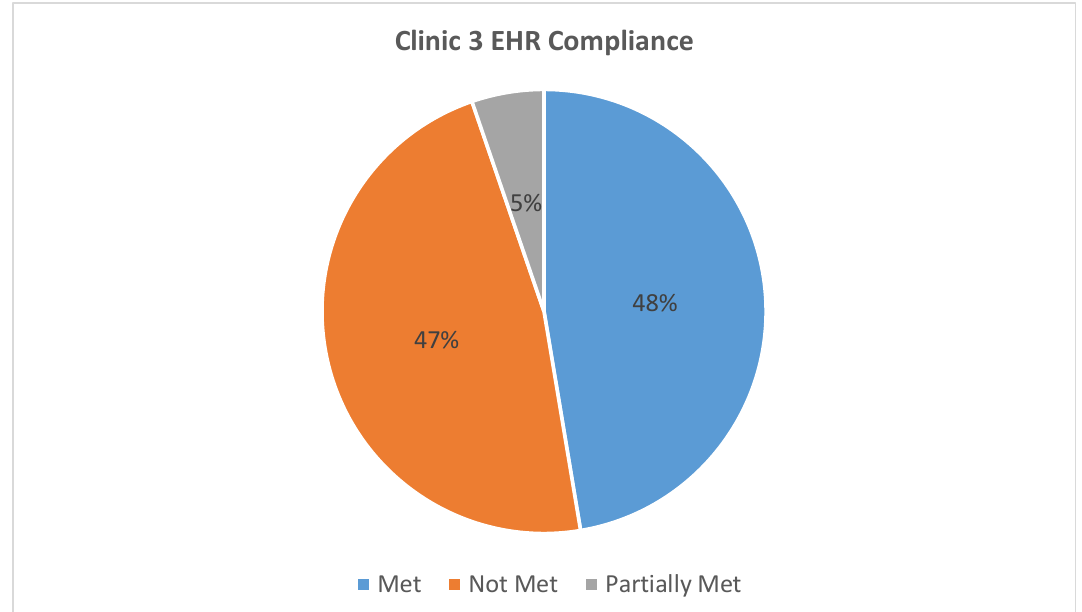
Figure 3. Clinic 2 EHR compliance with AAP recommendations.